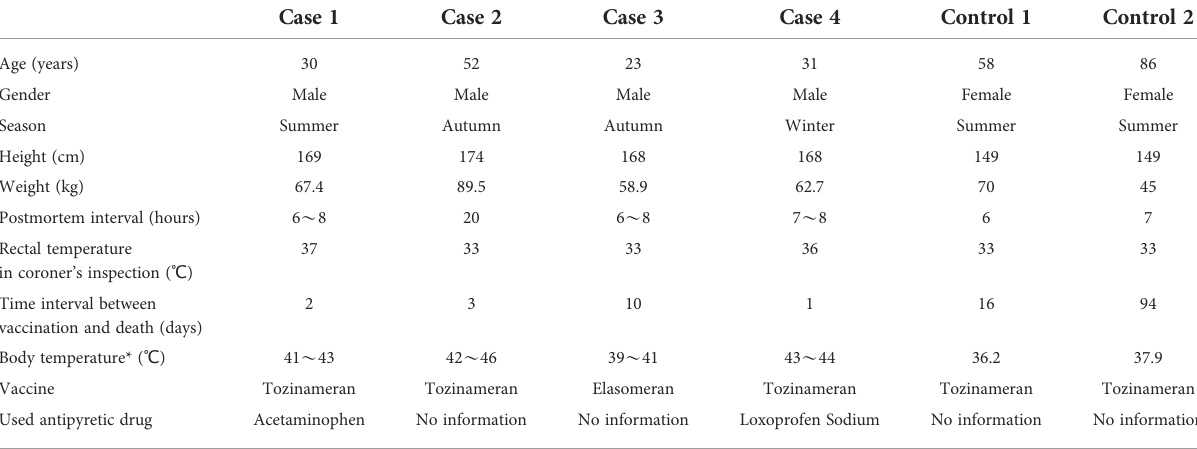
TABLE 1 Pro fi les of investigated 4 fatalities and 2